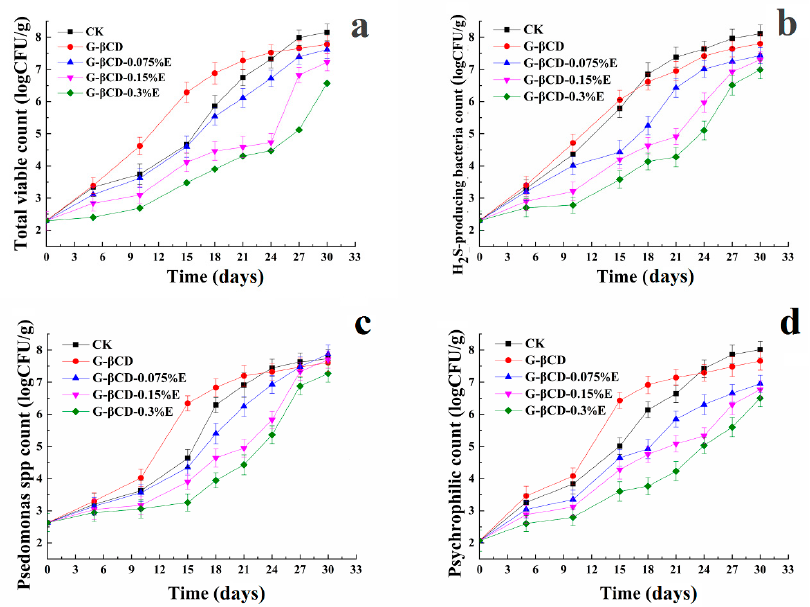
Figure 1. Changes in total viable count ( a ), H 2 S-producing bacteria ( b ), Pseudomonas spp. ( c ), and Psychrophilic counts ( d ) of Chinese seabass during superchilling storage at − 0.9 °C. (CK: uncoated; G- β CD: gelatin- β -cyclodextrin coating without eugenol; G- β CD-0.075%E: gelatin- β -cyclodextrin coating with 0.075% eugenol; G- β CD-0.15%E: gelatin- β -cyclodextrin coating with 0.15% eugenol; G- β CD-0.3%E: gelatin- β -cyclodextrin coating with 0.3% eugenol).